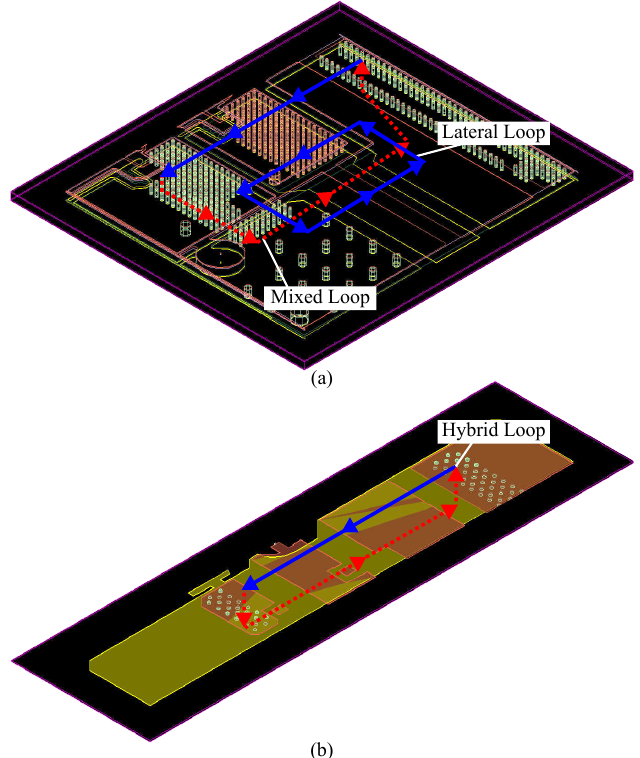
Figure 14. Power converters modelled in ADS: ( a ) bottom-side cooled converter; and ( b ) top-side cooled converter. The top-side currents are drawn using blue lines. The currents that flow through inner layers are drawn using red dashed